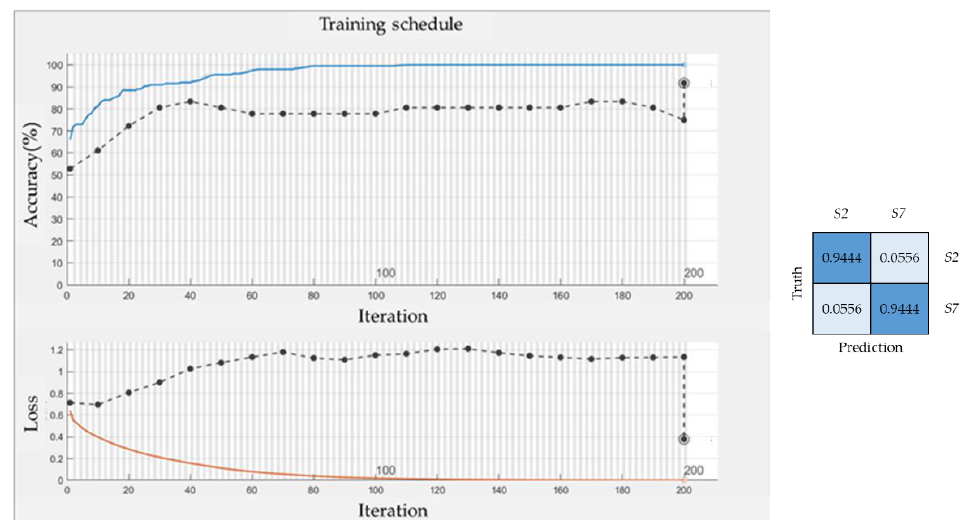
Figure 16. The training process of CNN and detection results.